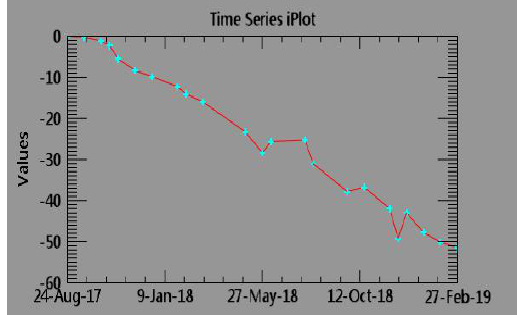
Figure 6. Chenzhuang funnel transformation